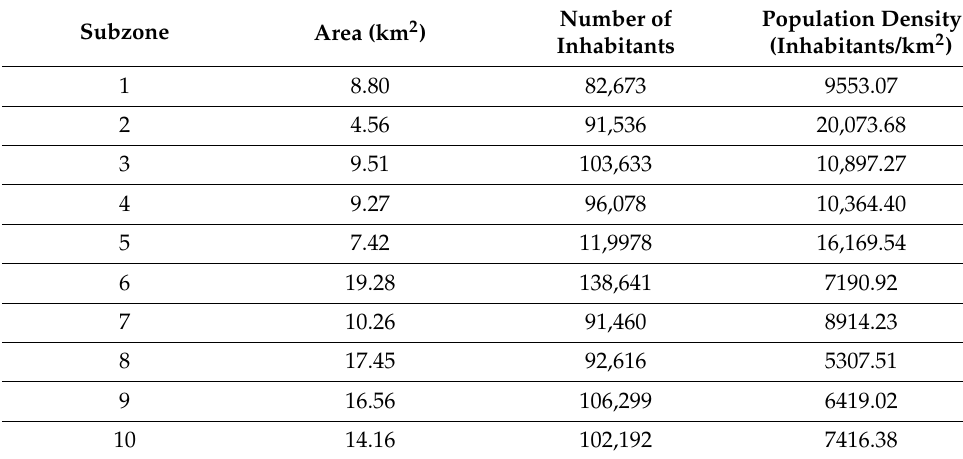
Table 3. Surface and population data in the ten municipalities of Naples (Italy).